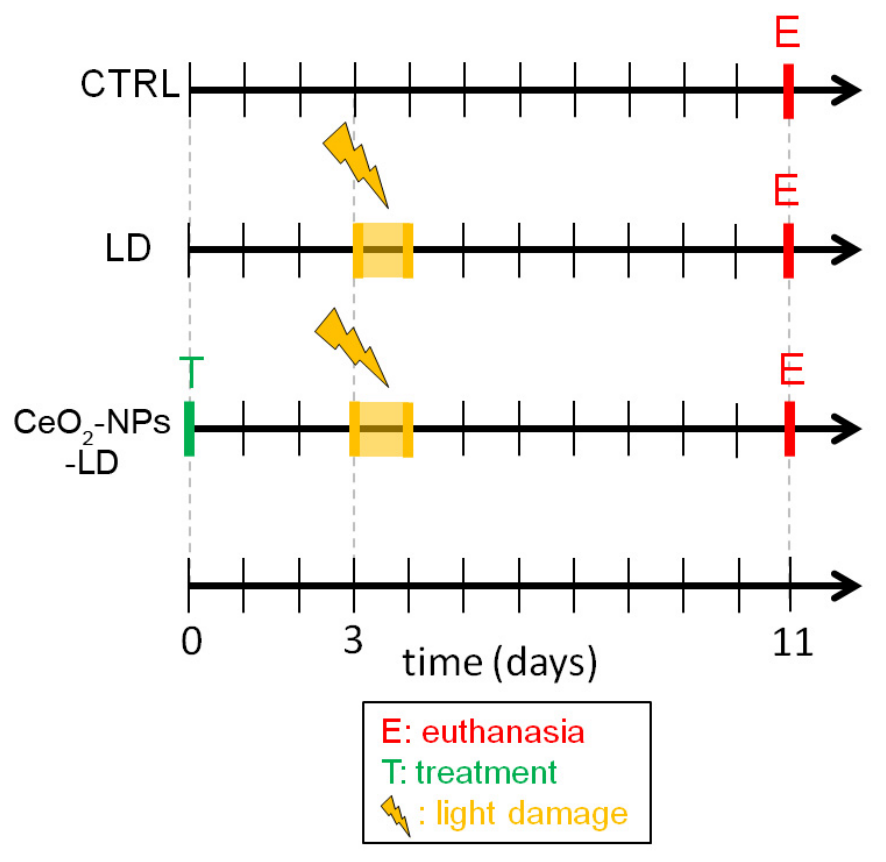
Figure 1. Experimental design of the in vivo study. The in vivo experiments were performed on Sprague Dawley albino rats divided in three experimental groups ( N = 4/group). (1) CTRL: control group of animals without retinal damage or treatment; (2) light damage (LD): animals subjected to light damage for 24 h and then euthanized seven days thereafter; (3) CeO 2 -NPs-LD: animals treated with cerium oxide nanoparticles via intravitreal injection, then subjected to light damage for 24 h and euthanized seven days later.